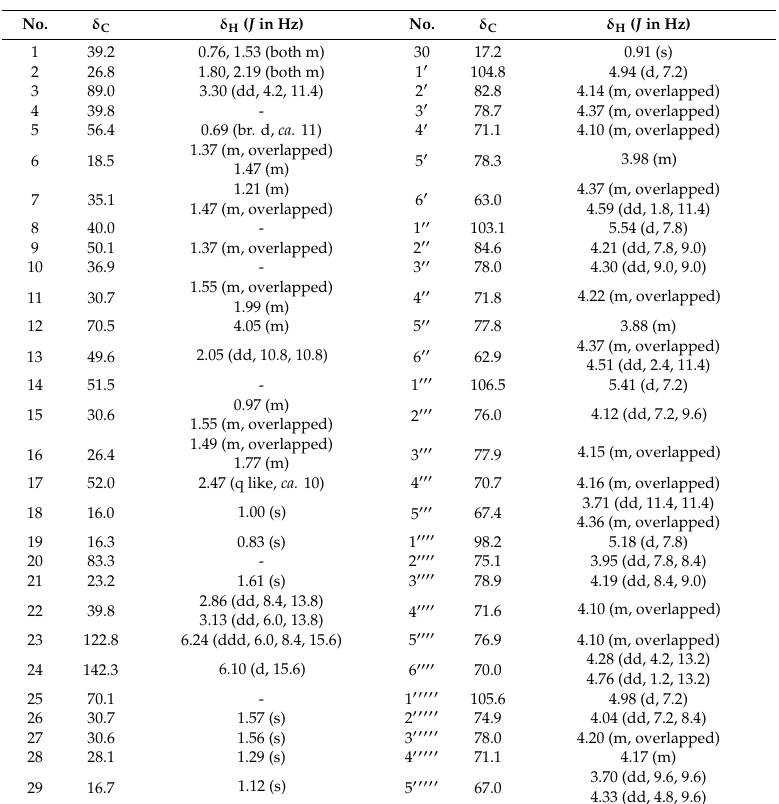
Table 7. The 1 H and 13 C-NMR data for 7 in C 5 D 5